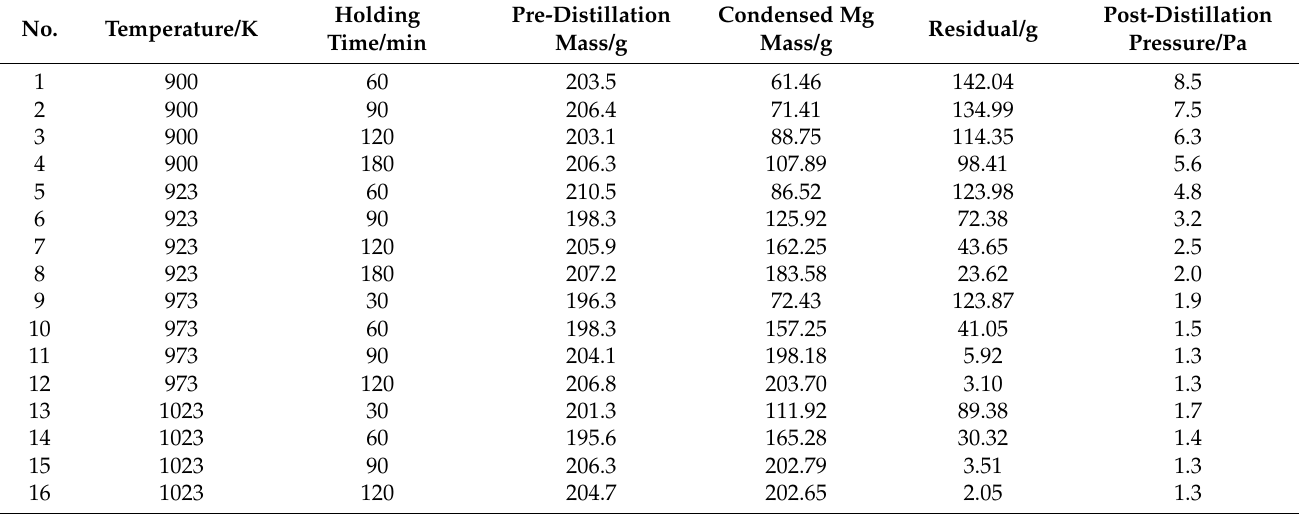
Table 3. Vacuum distillation parameters used for the different